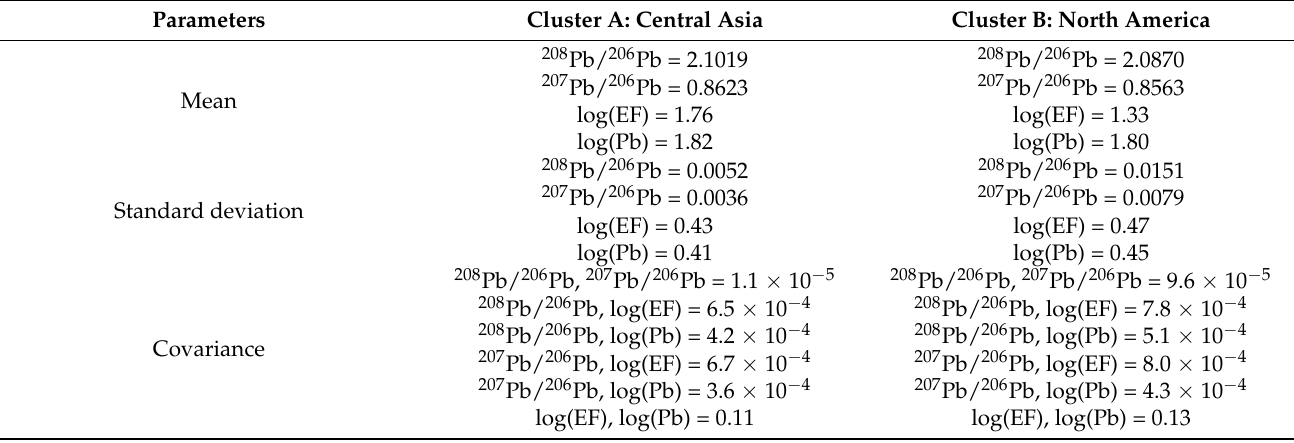
Table 2. Parameters for the two clusters resulting from Gaussian Mixture Modeling (GMM) on Pb isotope ratio, enrichment factors (EFs), and Pb concentration values measured in PM 10 samples collected at Ny-Ålesund from 2010 to 2018. Parameters Cluster A: Central Asia Cluster B: North America 208 Pb/ 206 Pb = 2.1019 207 Pb/ 206 Pb = 0.8623 Mean log(EF) = 1.76 log(Pb) = 1.80 Standard